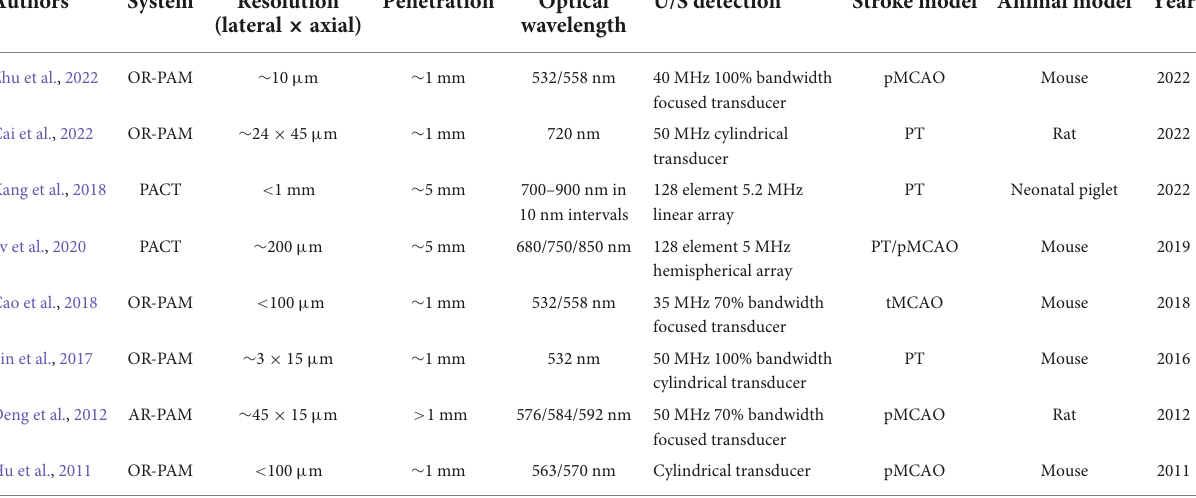
TABLE 1 Summary of major publications on ischemic stroke using PAI in the past